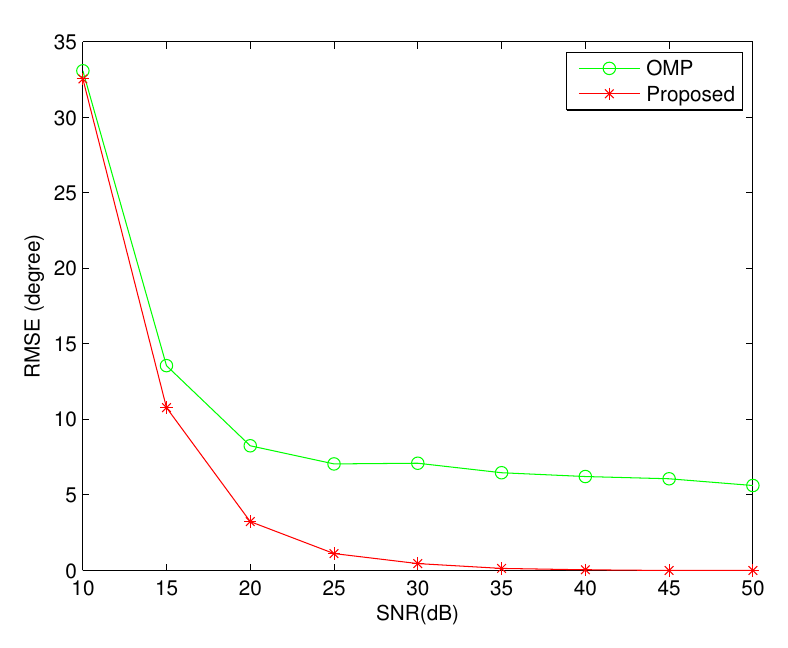
DOAs: {− 36 ◦ , 4 ◦ , 8 ◦ , 54 ◦ } . The minimal DOA difference is 4 ◦ . The curves were obtained by averaging the results of 100 independent simulation runs.